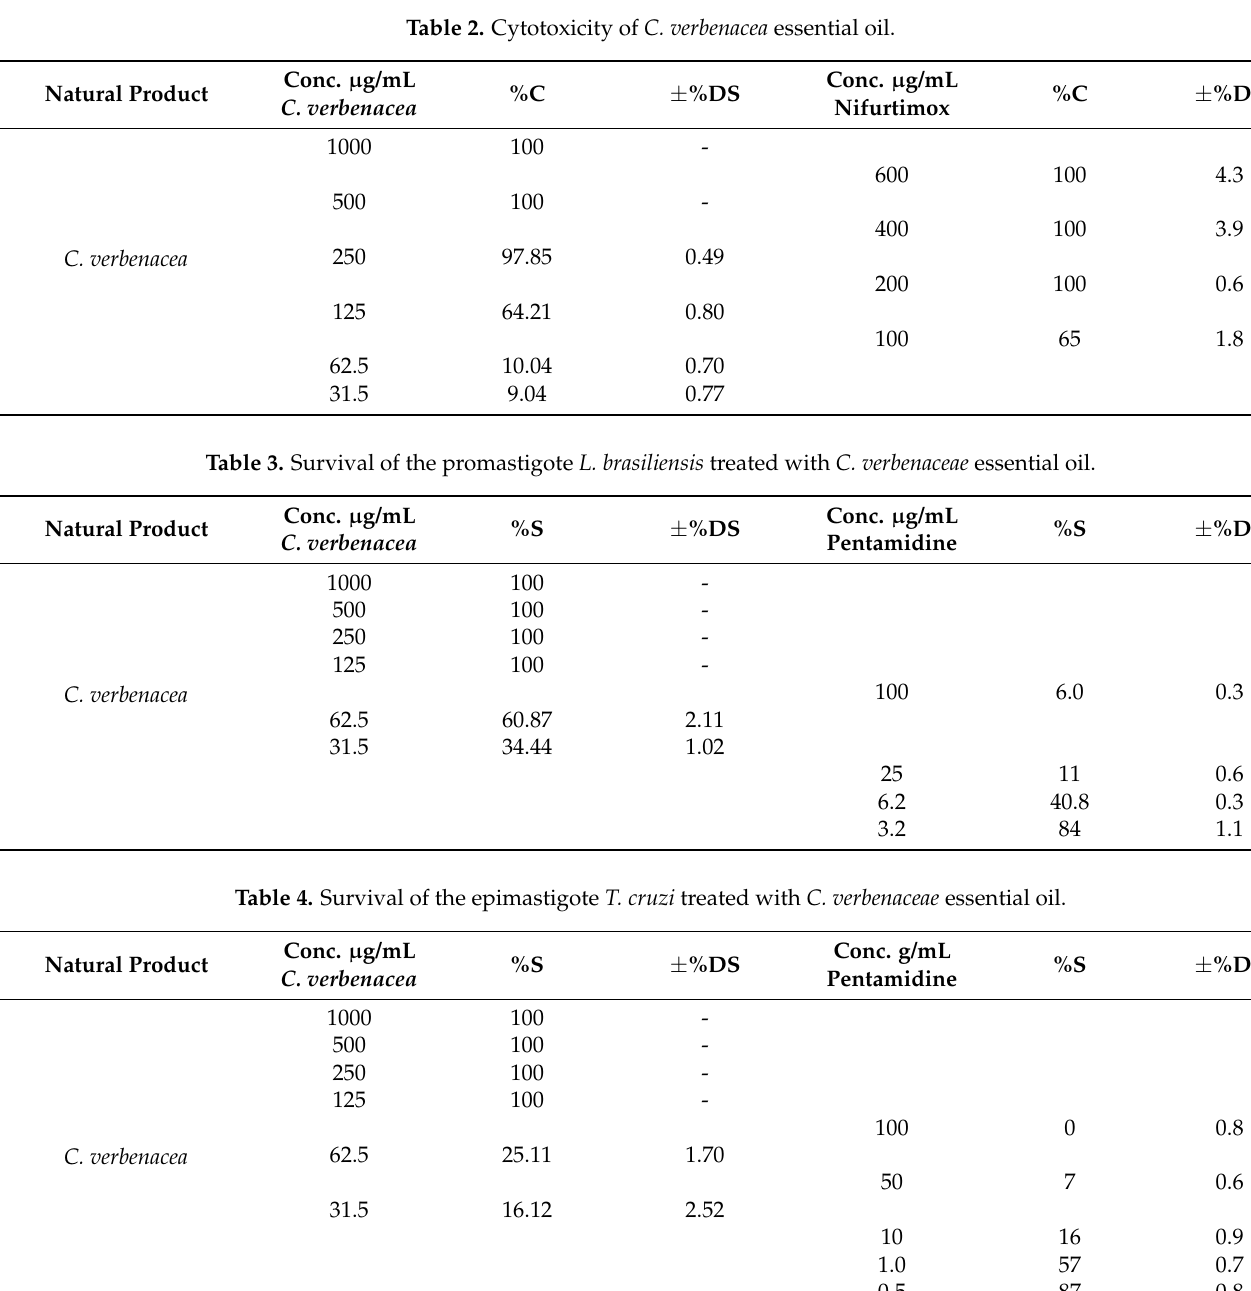
Table 2. Cytotoxicity of C. verbenacea essential oil.